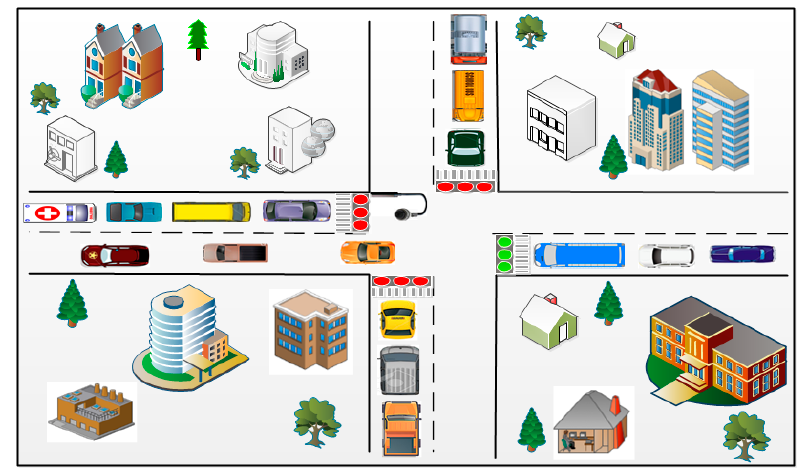
Figure 1. Emergency vehicle waiting at an intersection.